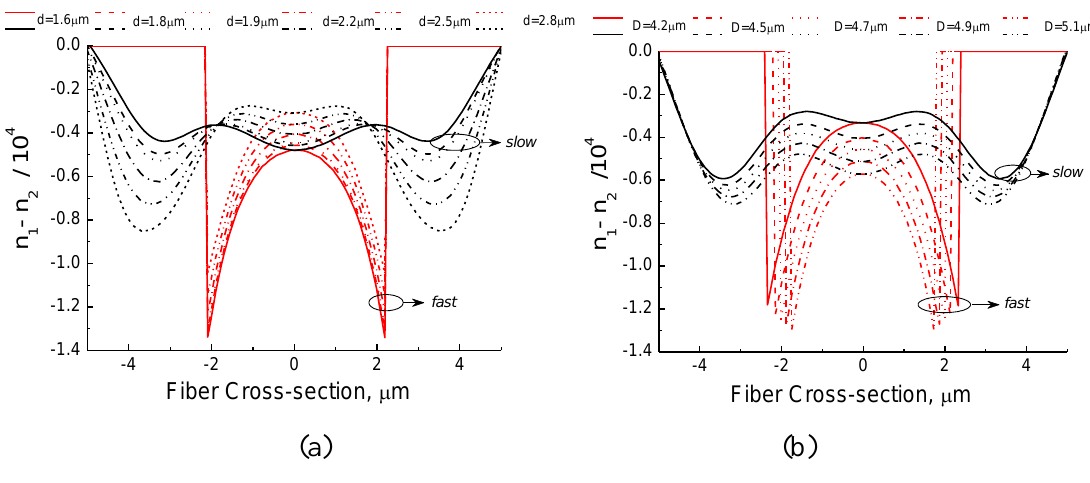
and 𝑛 along the slow 1 2